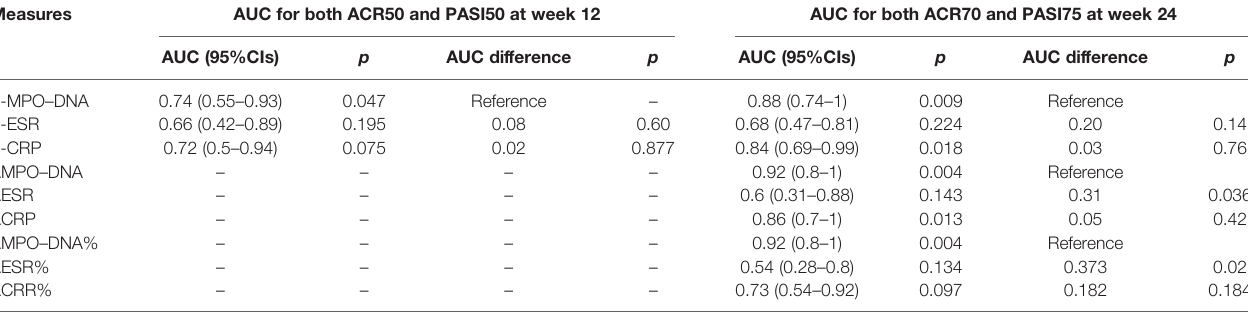
TABLE 5 | AUCs for treatment outcomes at weeks 12 and 24.